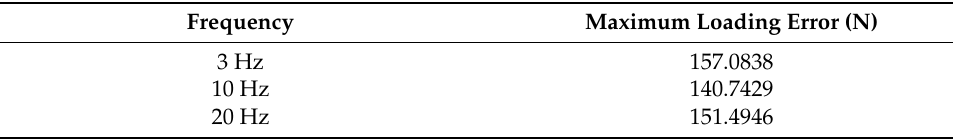
Figure 20. System loading error at different frequencies.